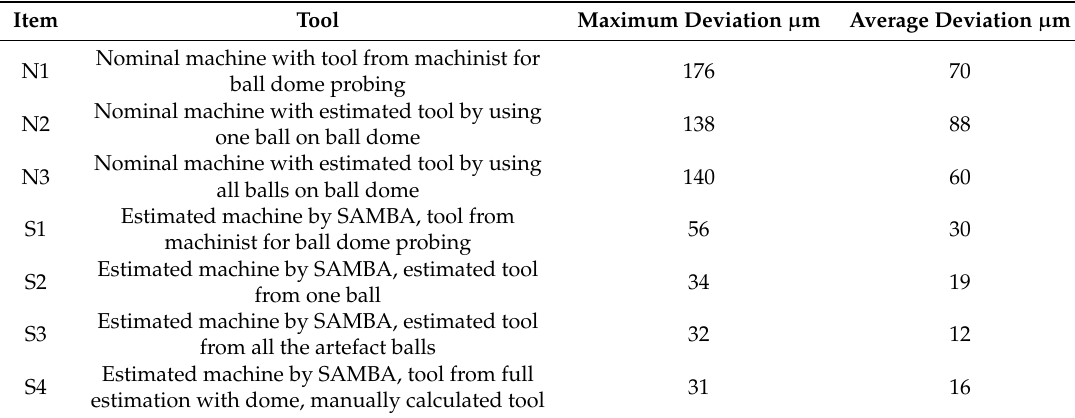
Table 5. Maximum and mean deviation for different models (µm).